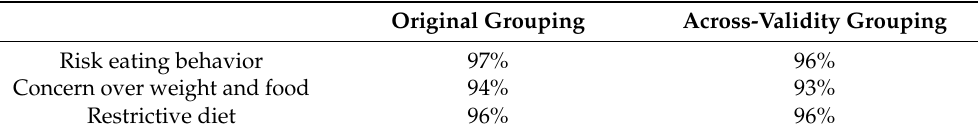
Table 1. Results of correct classification by predictor factor in original grouping and an across-validity grouping. Original Grouping Across-Validity